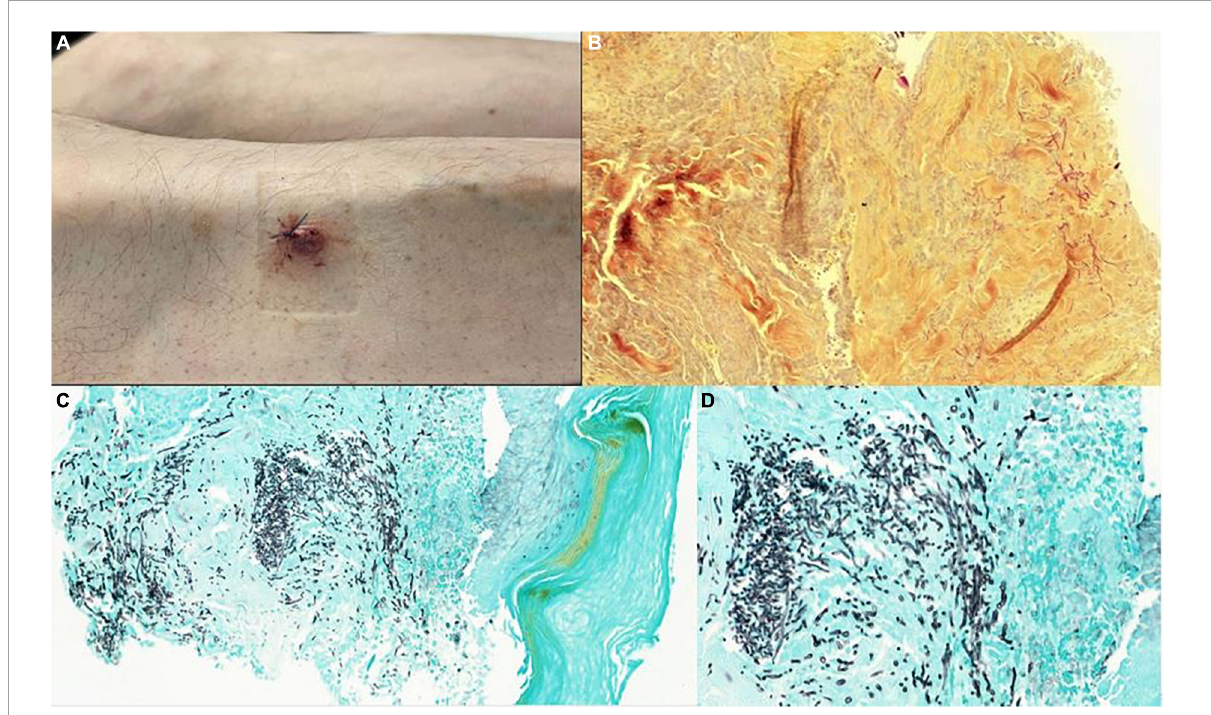
FIGURE1 Painful purplish cutaneous nodules (A) , pathology examination with Periodic Acid Schiff coloration 10x (B) , and colorations with GROCOTT stain of cutaneous nodules showing regular septate filaments connected with 45-degree divisions 10x (C) and 40x (D) .